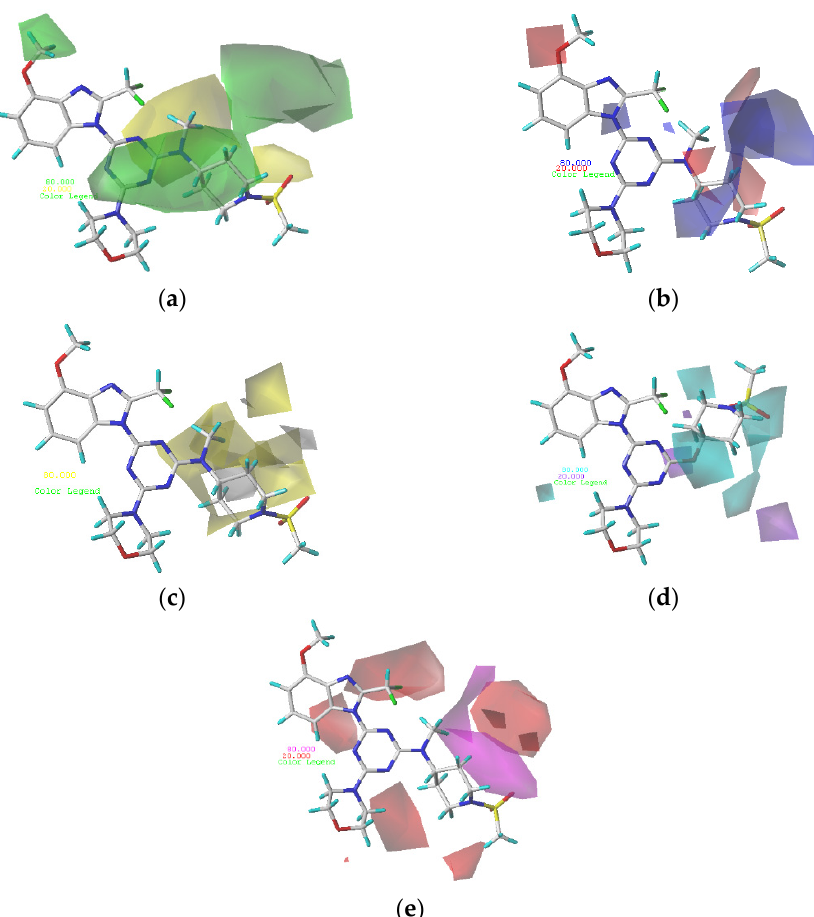
Figure 3. ( a ) Steric contour maps of CoMSIA; ( b ) electrostatic contour maps of CoMSIA; ( c ) hydro-